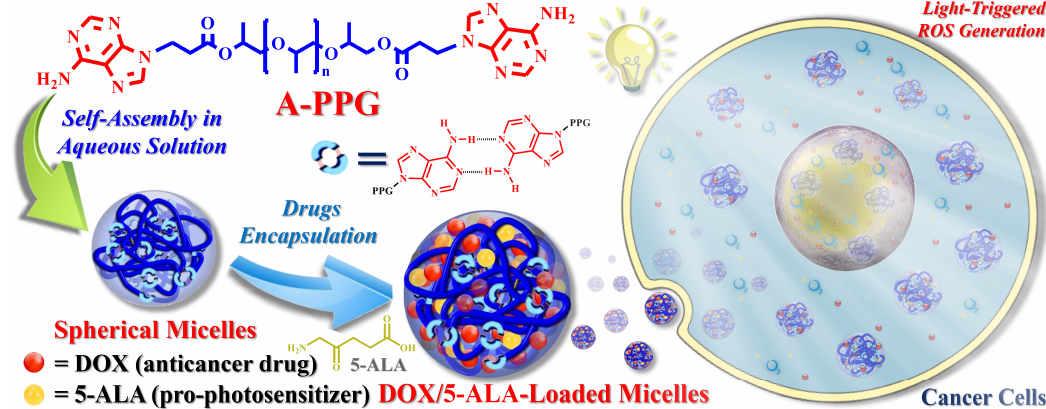
Scheme 1. Schematic illustration of light-triggered release of therapeutic agents from adenine-functionalized supramolecular micelles (A-PPG) micelles. Micelles encapsulating doxorubicin (DOX) and the pro-photosensitizer 5-aminolevulinic acid (5-ALA) are internalized and distributed in cancer cells via endocytosis. Activation of the DOX/5-ALA complexes within the micelles with visible light induces degradation of the micelle structure and release of DOX, which results in tumor cell